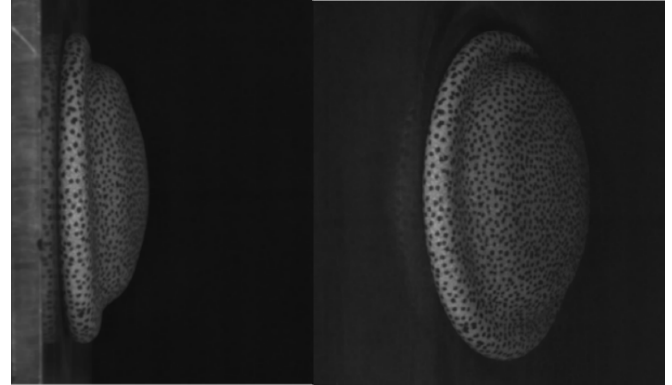
Figure 6. Example impact frames with loss of surface tracking for impacts at 52.5 m ∙ s − 1 and 90°.